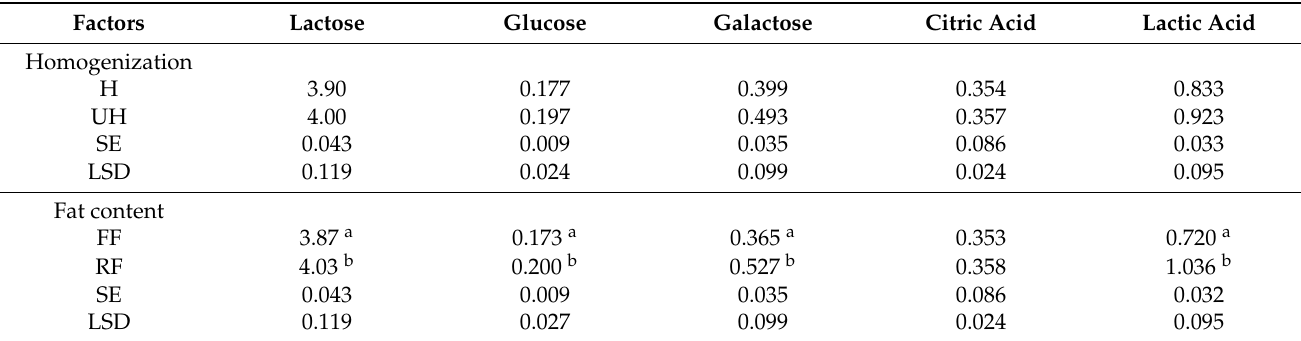
Table 3. Means of residual sugars and organic acids (g per 100 g cheese) of Quark-type cheeses made from unhomogenized and homogenized full-fat and reduced-fat milk heated under different